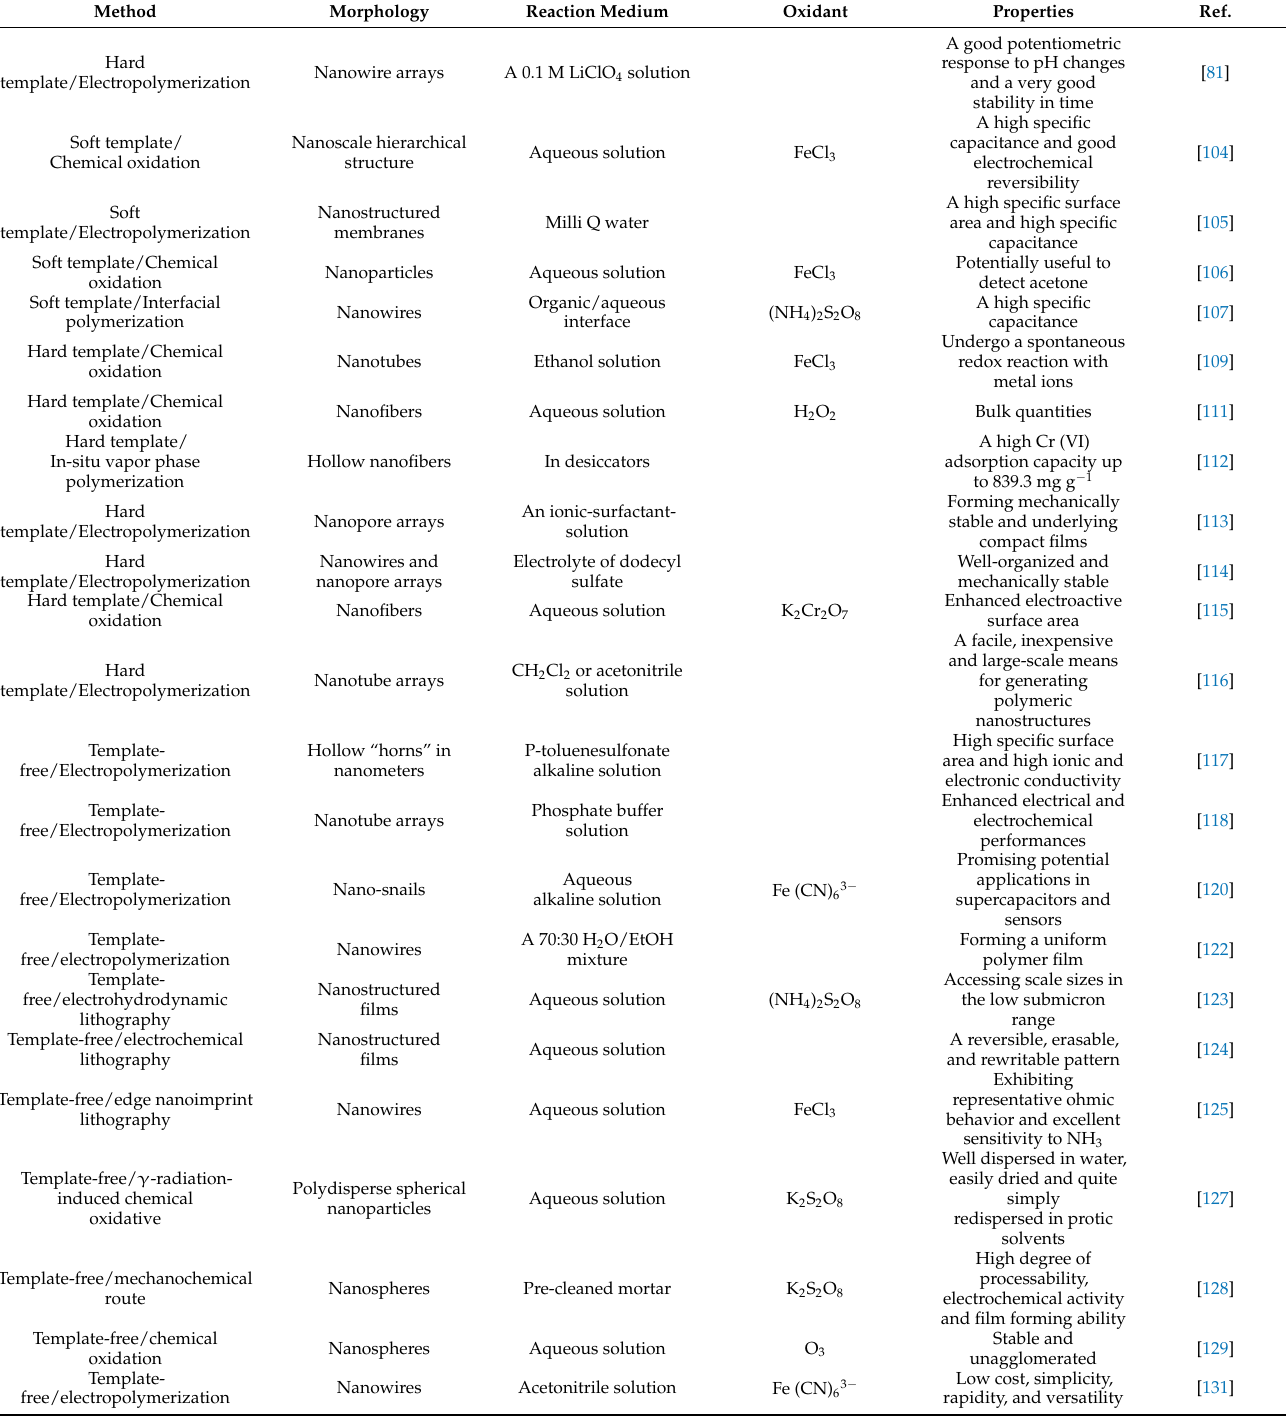
Table 2. A summary of preparation methods, morphology and properties of PPy